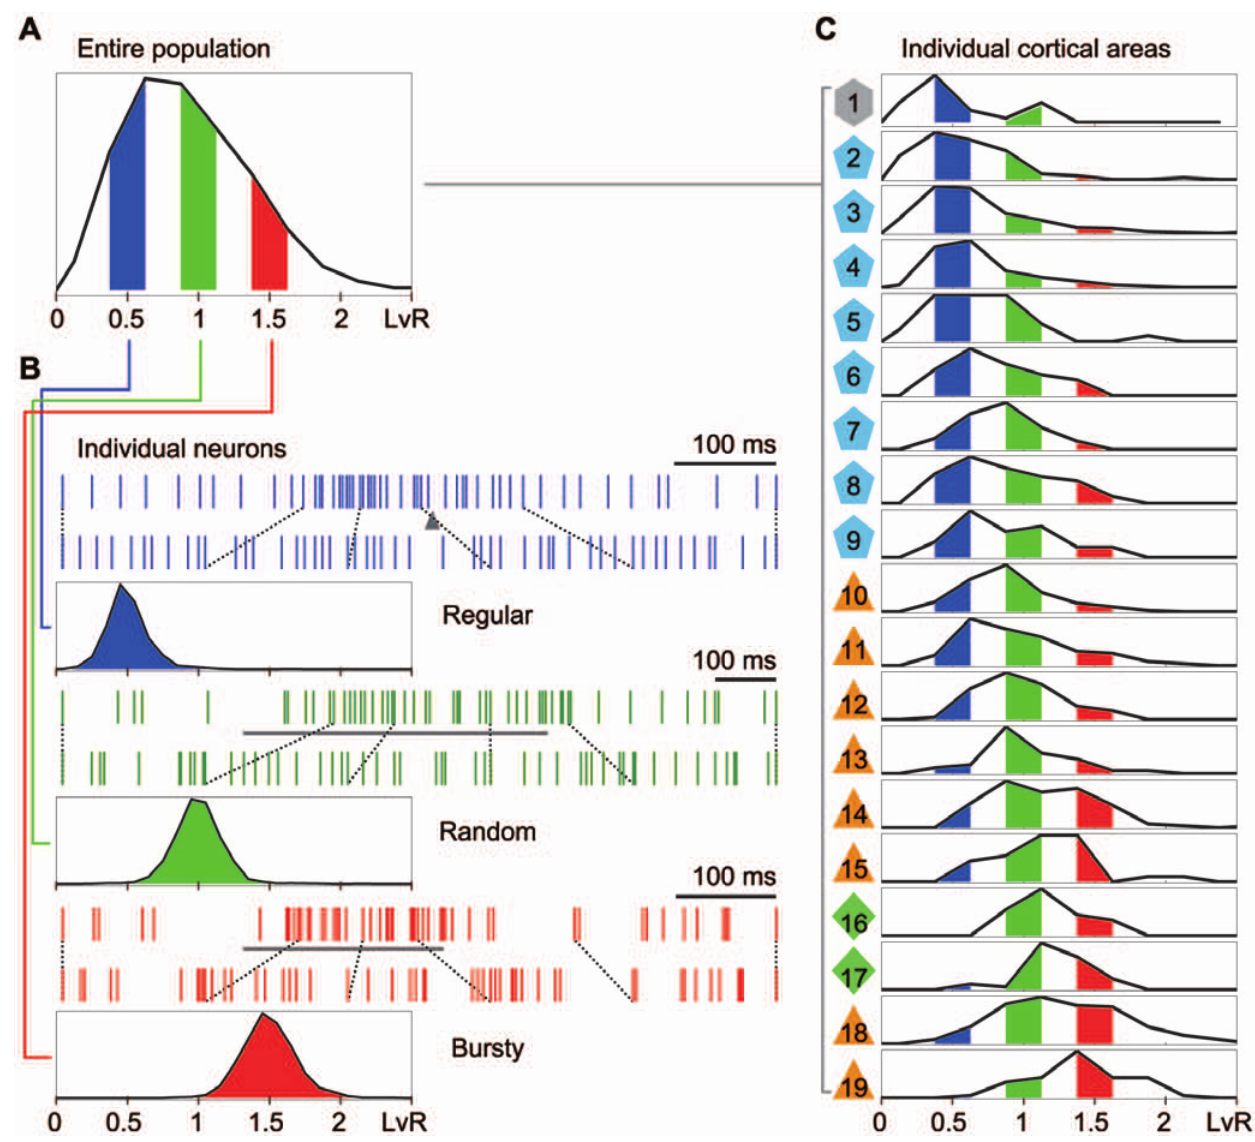
Figure 3. LvR distributions for the entire population and subpopulations of neurons. (A) The distribution of LvR determined across 2,000 ISI sequences for all 1,307 cortical neurons. (B) Top: Original and rescaled specimen spike sequences of representative neurons with an LvR of 0.5, 1.0, and 1.5 taken from data sets # 2 (SMA), # 10 (TE) and # 19 (MT). Triangle and horizontal bars for the three original spike sequences indicate the onset of wrist movement and periods of visual stimulation, respectively. Dashed lines indicate the correspondence between the original and the rescaled fractions (10 ISIs) for which the time-scale is normalized to the average firing rate of that fraction. Bottom: Metric distributions for fractional sequences derived from neurons whose representative (mean) LvR values are within the range of 6 0.05 around 0.5, 1.0, and 1.5 (blue, green and red bars in A , n=92, 91 and 60). (C) LvR distributions for the 19 neuronal data sets (Table 1), shown in order of ascending mean LvR . The primary motor, higher-order motor, visual, and prefrontal areas are indicated as hexagons, pentagons, triangles, and squares,